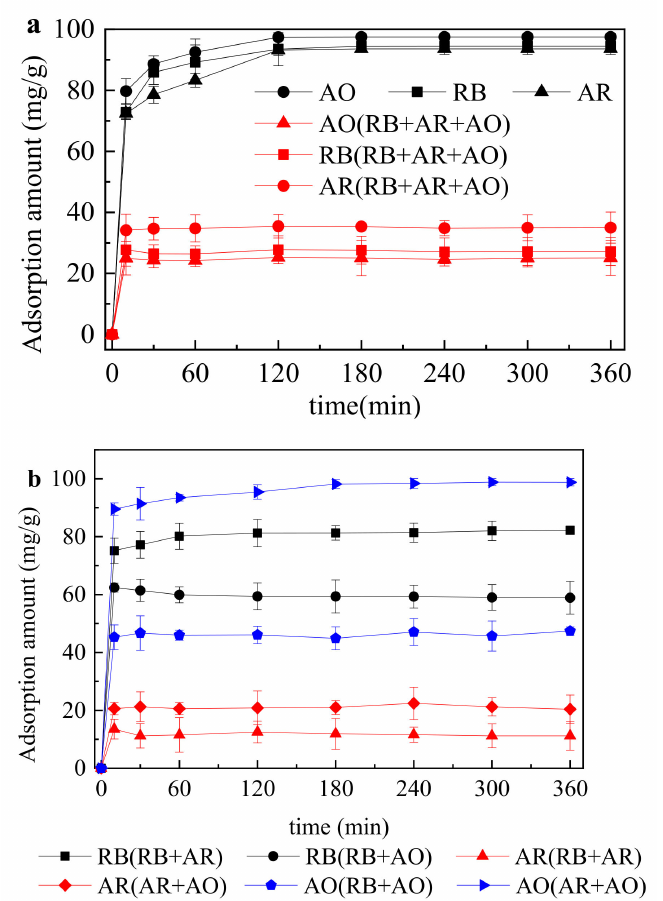
Figure 5. E ff ect of adsorption duration on the Acid Orange II (AO), Reactive Blue (RB) and Acid Red (AR) adsorption performance. ( a ) one component and three component system; ( b ) two component system.